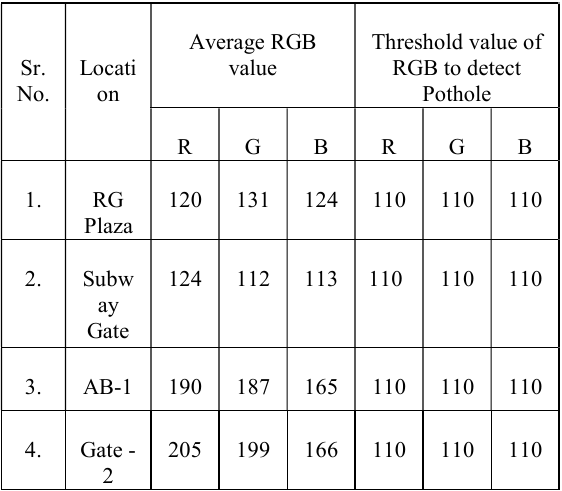
Table 2 . Result of pothole for different locations of RGIPT for RGB